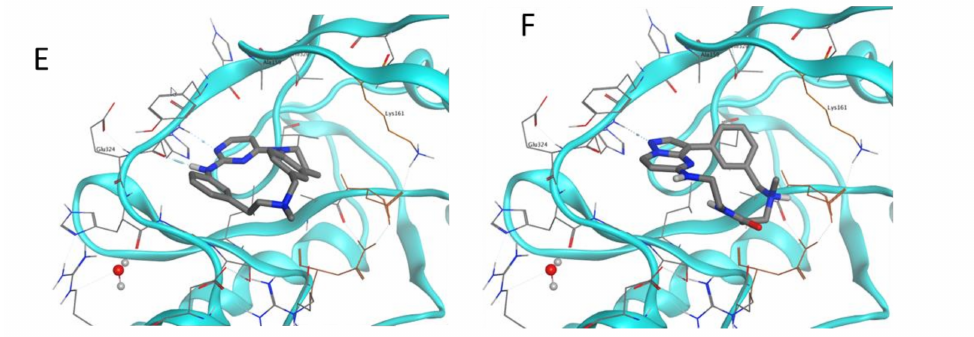
Figure 1. Structure and kinase profile of OD16 and OD29. ( A – C ) Chemical structure and the activity of a panel of 96 kinases in the presence of 100 nM of OD16 ( A ), OD29 ( B ), and LDN-193189 ( C ). ( D ) Affinity (Kd) of OD16, OD29, and LDN-193189 for the BMP, activin, and TGF- β type I and type II kinase receptors. ( E , F ) Structural model of OD16 ( E ) and OD29 ( F ) binding to the ALK1 hinge region in the ATP